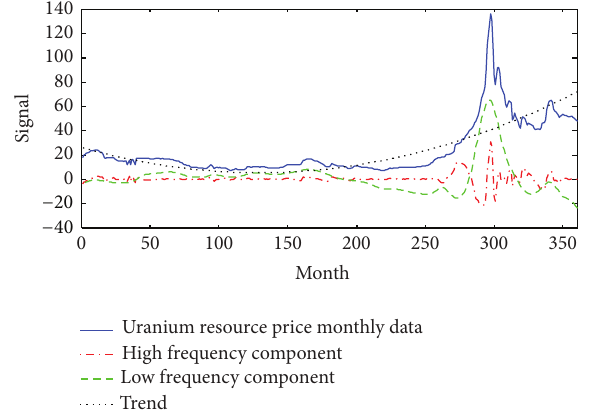
Figure 7: Three components of uranium resource price monthly data series from Oct. 1982 to Sept. 2012.